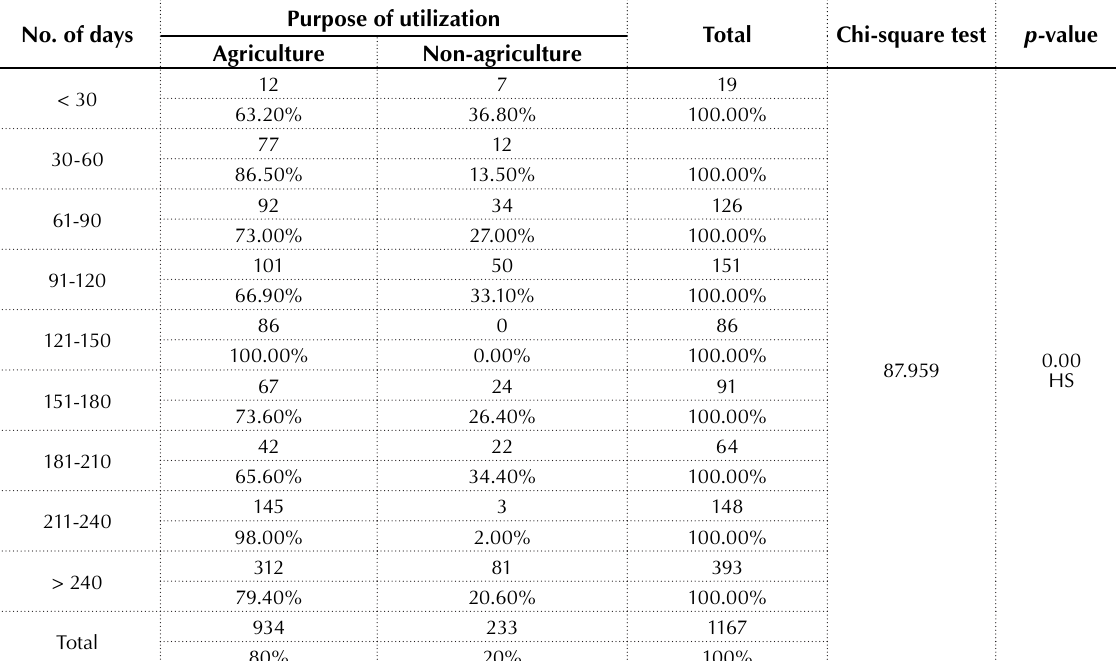
Source: Primary data.